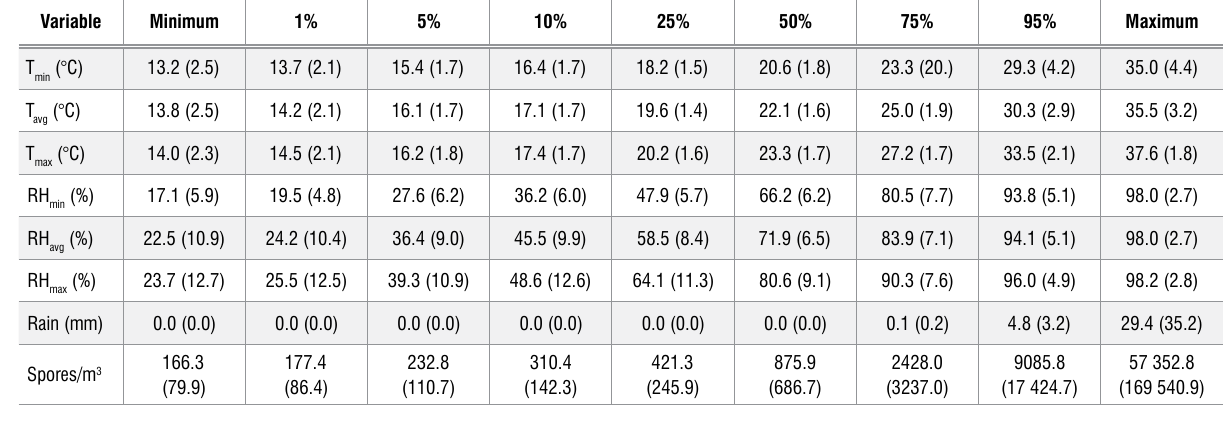
Prediction of first seasonal release of Phyllosticta ascospores by the DDwet pseudothecium maturation model [probability of first ascospore event = exp(-exp(-(-3.131 + 0.007 × DDtemp -